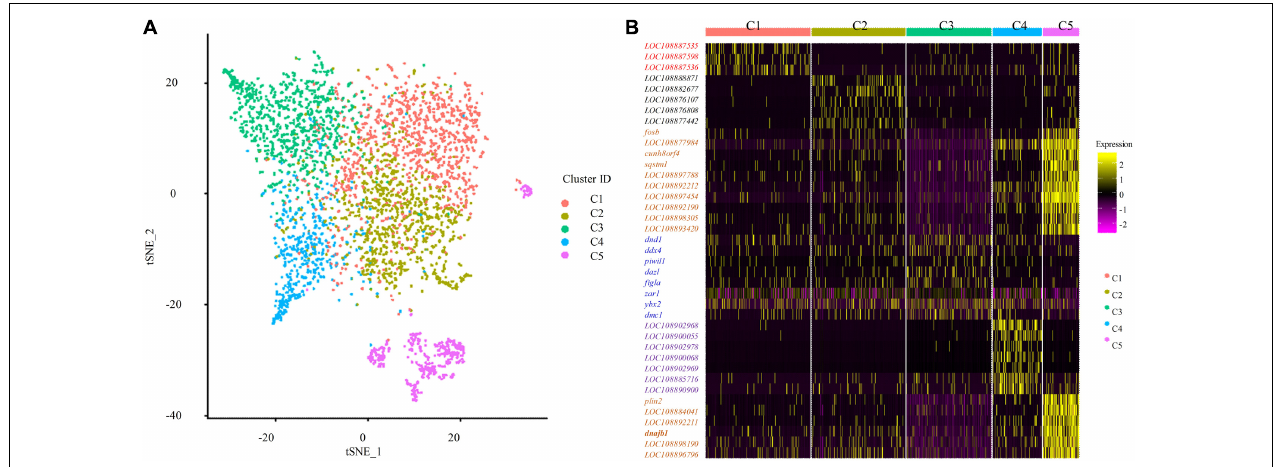
FIGURE 2 | Single cell transcriptome profiling of Asian sea bass ovary. (A) Two-dimensional t-SNE and clustering analysis of single-cell transcriptome data. Colors represent different cell types. tSNE, t-distributed stochastic neighbor embedding. (B) Heatmap of positive marker genes and negative marker genes in all five